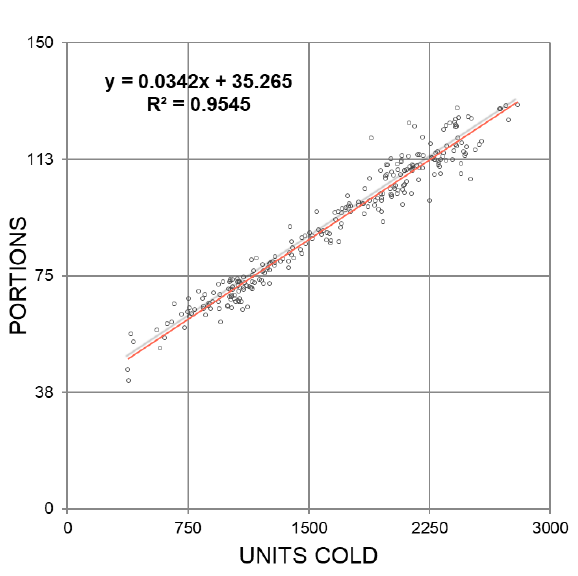
Figure 8. Data sets used and expected